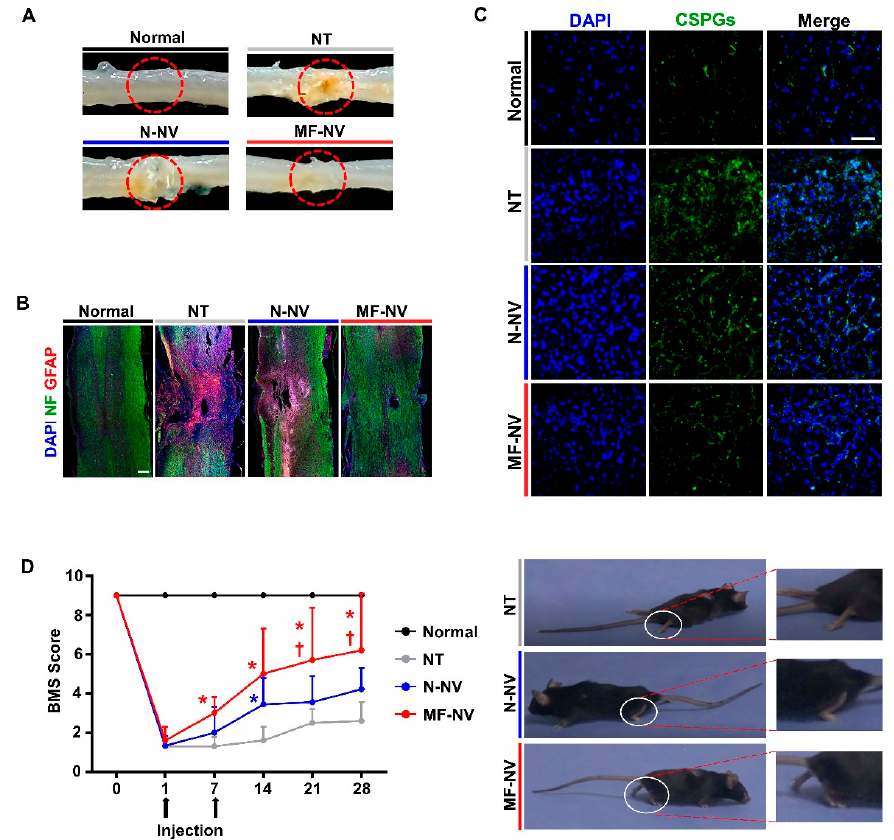
Figure 7. Reduced glial scar formation and improved function recovery by MF-NVs in SCI mice. ( A ) Representative images of spinal cord retrieved 28 days after the NV injection. The dotted red circles indicate the lesion core. ( B ) Representative images of immunohistochemical staining for neuron (NF, green) and astrogliosis (glial fibrillary acidic protein (GFAP), red) in longitudinal sections of spinal cord 28 days post-injury (n = 4 animals per group). Scale bars, 200 µ m. ( C ) Representative images of immunohistochemical staining for glial scar-related component (CSPGs, green) at the lesion core 28 days post-injury (n = 4 animals per group). Scale bars, 20 µ m. ( D ) Basso mouse scale (BMS) score-based quantitative analysis of time-lapse functional recovery in spinal cord-injured mice and the representative images of injured animals 28 days post-injury (n = 8 animals per group). The white circles indicate the ankle movement. * p < 0.05 versus NT and † p < 0.05 versus N-NV by using two-way ANOVA followed by post-hoc Bonferroni test. All values are mean ± SD. NT indicates no